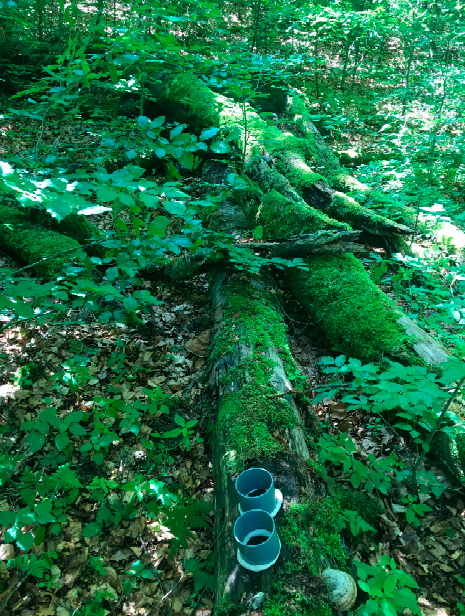
Figure 1. Beech downed dead wood with measurement collars in Zofin Forest in central Europe.